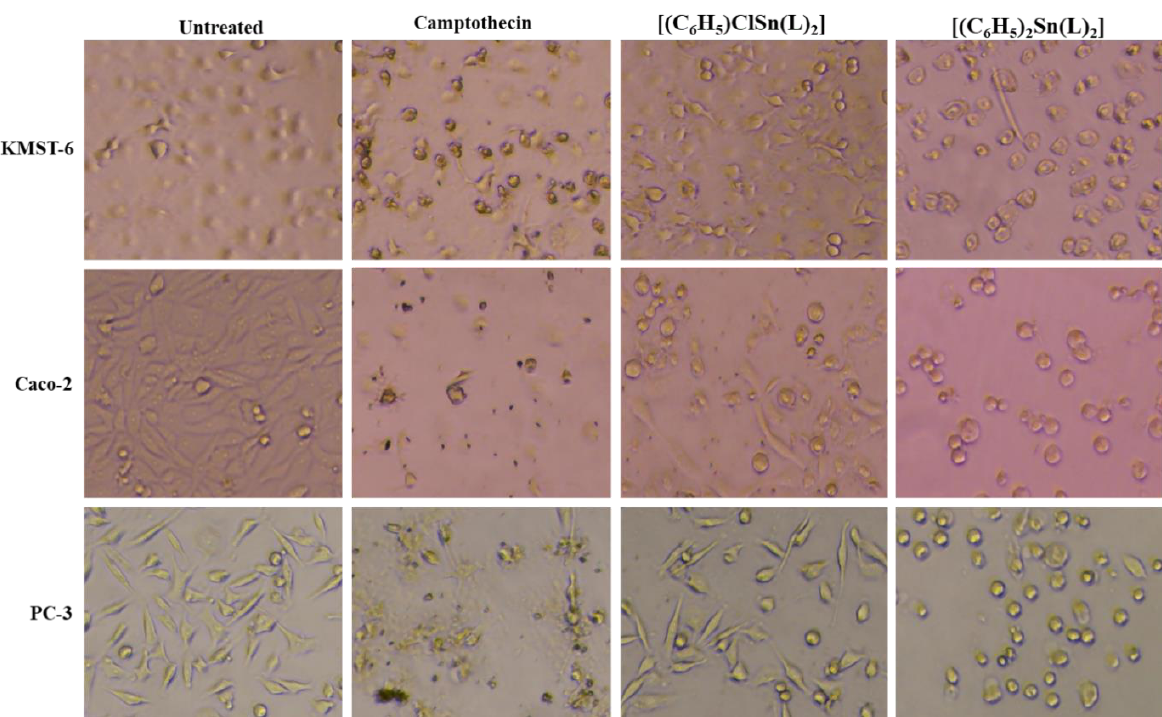
Figure 4. Effect of the phenyltin(IV) complexes [(C6H5)2Sn(L)2] and [(C 6 H 5 )(Cl)Sn(L) 2 ] and Camp- tothecin on cellular morphology after 24 h treatment with 100 µM. Table 3. The IC 50 of the mono-and di- phenyltin(IV) N -methyl- N -hydroxyethyldithiocarbamate complexes and camptothecin.